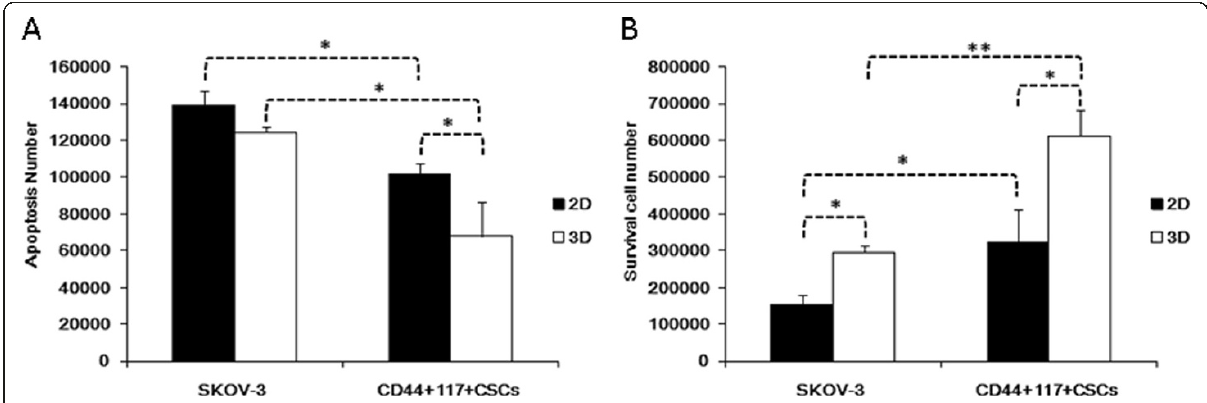
Figure 5 Less apoptosis and more survival of CD44 + 117 + CSCs than SKOV-3 cells in 3D culture versus 2D one. A shows the cell apoptotic results detected by Cell Titer-Glo W Luminescent cell viability measurement. B indicates the survival cell numbers in the 3D and 2D culture respectively, from the test by Survival assay. Statistically significant differences are indicated by asterisk (*) for P < 0.05 or (**) for P < 0.03 .